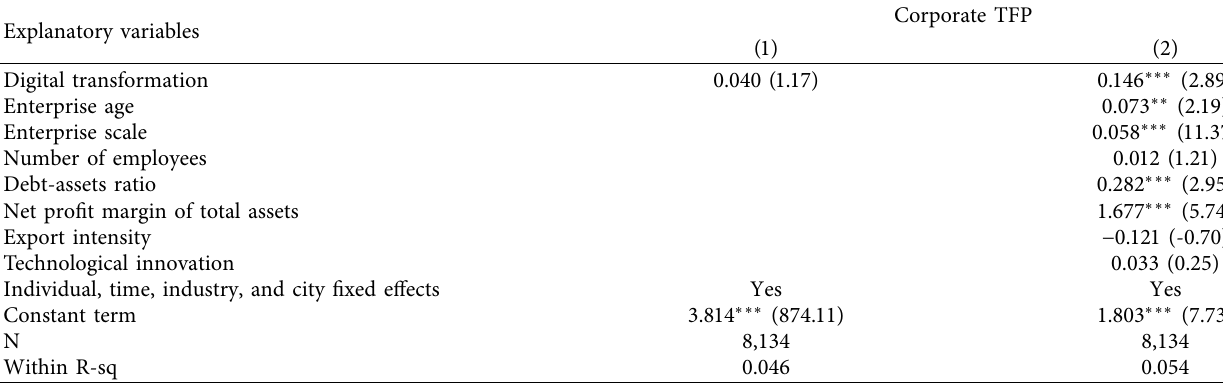
Table 2: Benchmark regression results.